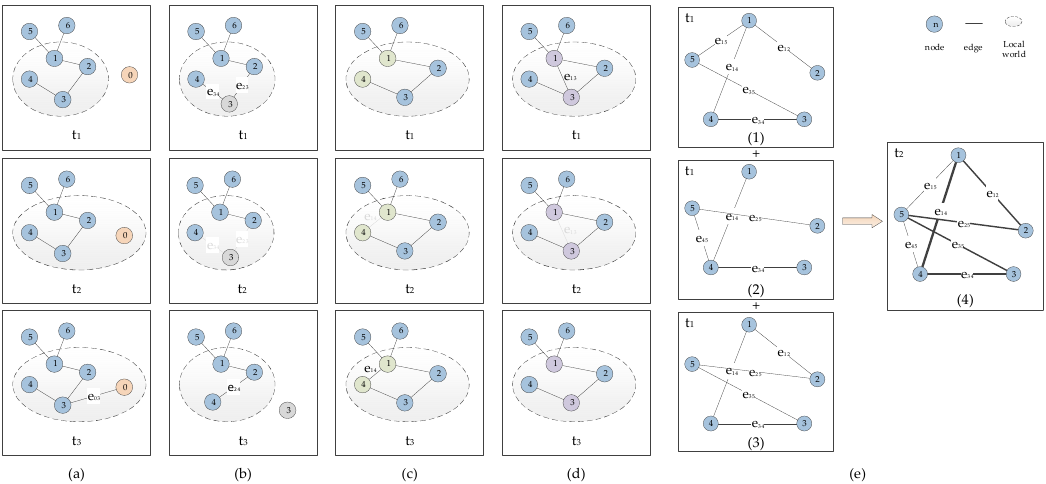
Figure 8. The local-world and edge-weight evolution mechanism of the space information network (SIN): ( a ) node increase mechanism; ( b ) node deletion mechanism; ( c ) edge increase mechanism; ( d ) edge deletion mechanism; ( e ) edge-weight evolution mechanism (adopted from Yu et al. [16]).